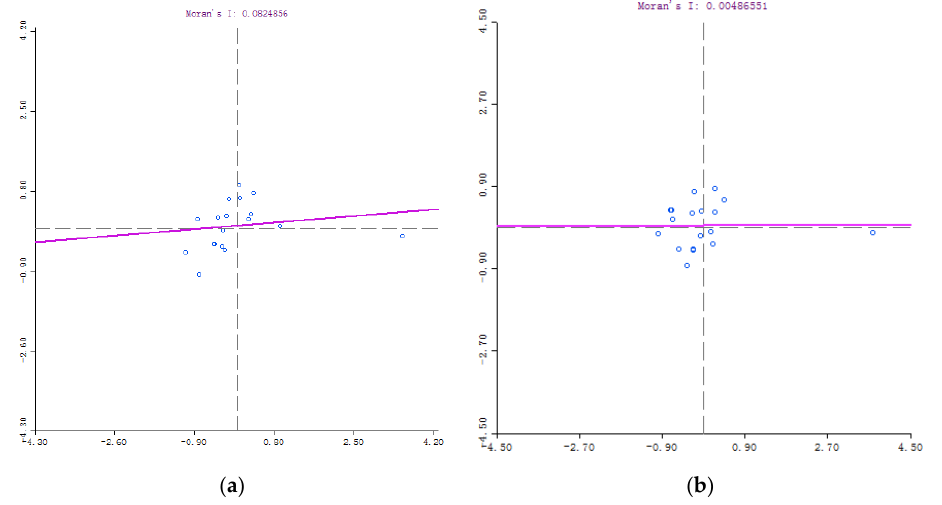
Figure 5. Moran scatter plot of the coupling degree of infrastructure construction and economic development level in Henan Province. ( a ): Moran’s I index in 2014. ( b ) Moran’s I index in 2017.